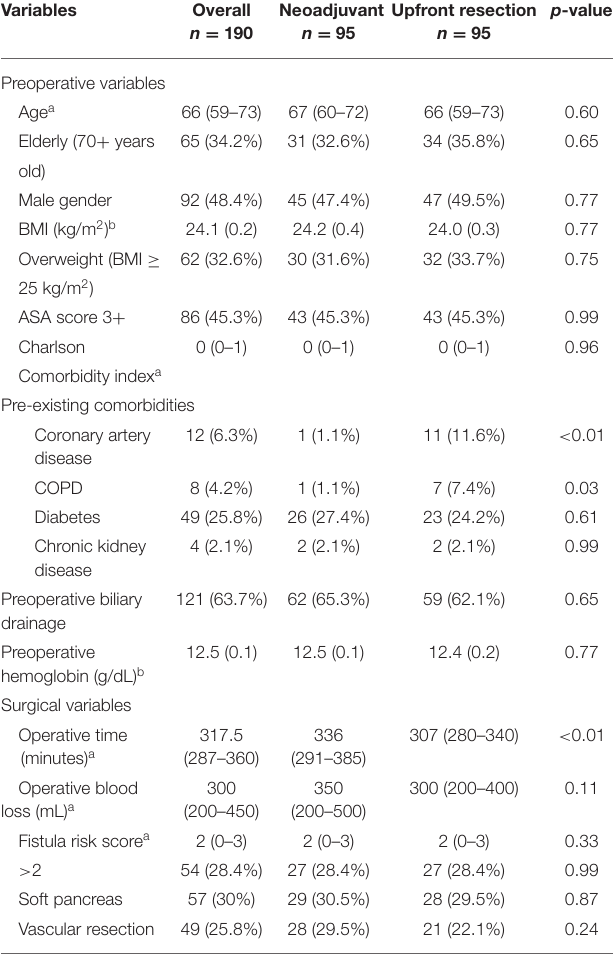
TABLE 3 | Preoperative and surgical characteristics after propensity score adjustment.